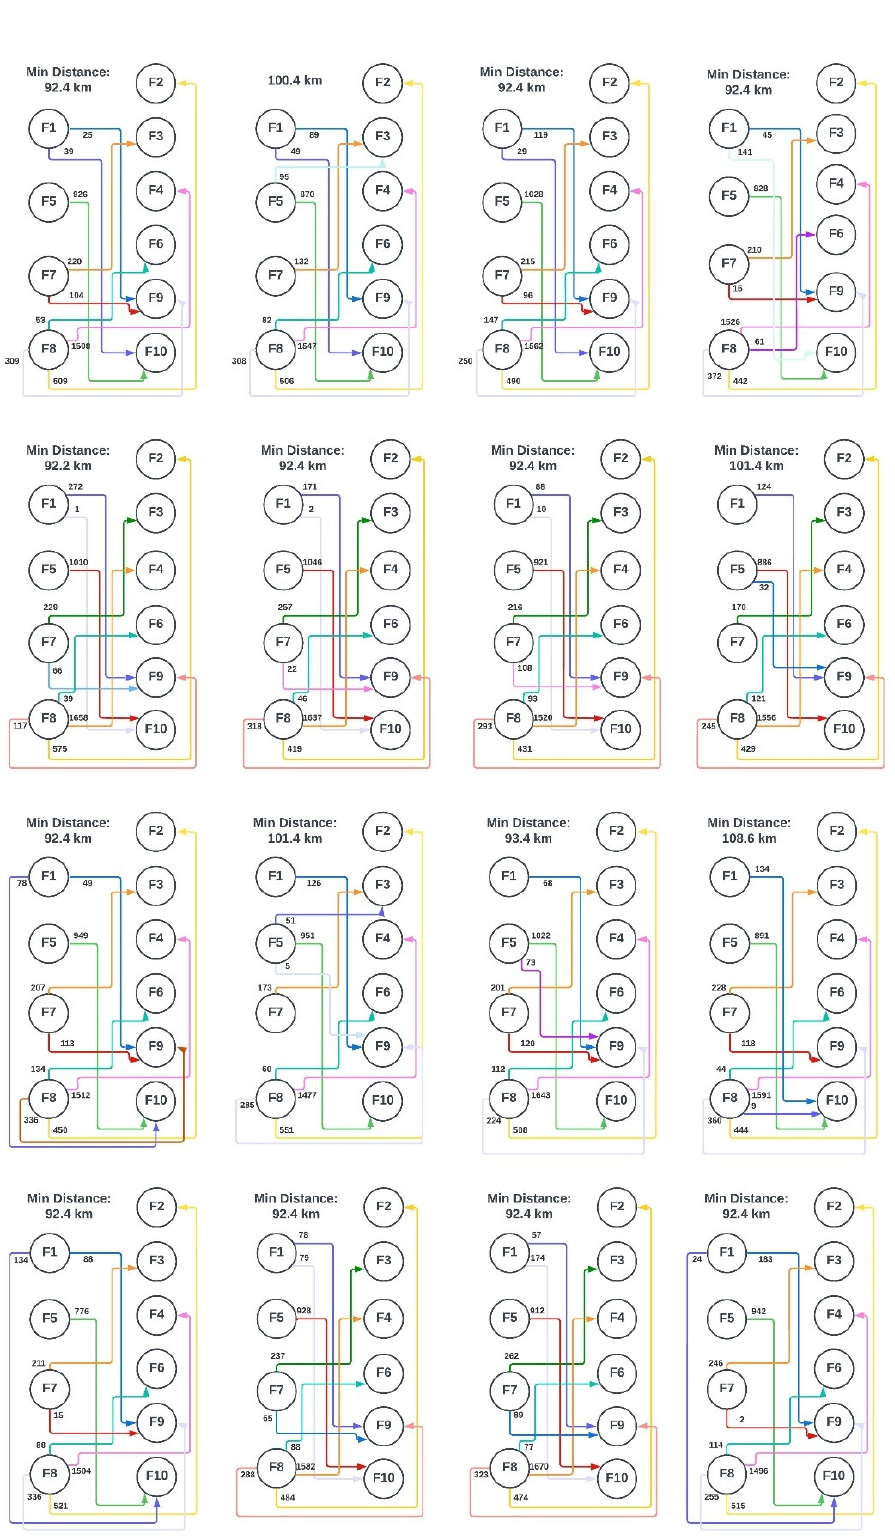
Figure 15. Food exchange between the urban farms as a result of the food supply chain.